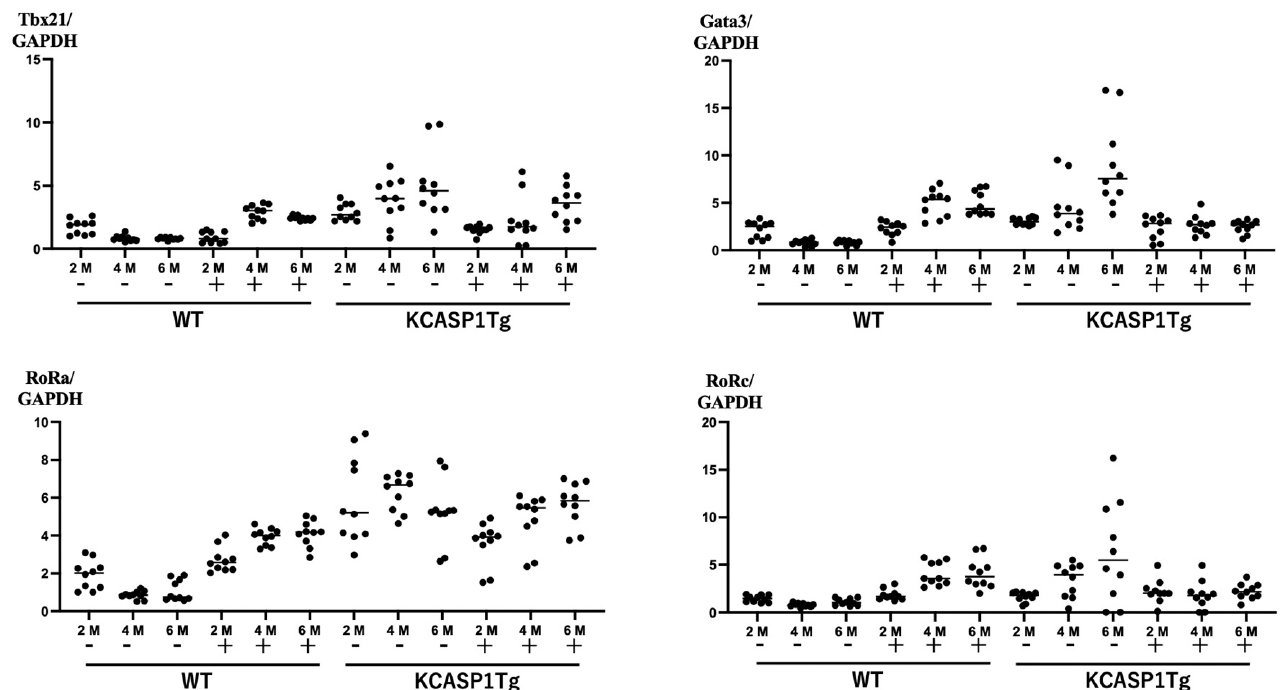
Figure 3. Expression of nuclear transcription factors. The graphs represent the relative expression of the indicated transcription factors with respect to the housing-keeping gene-GAPDH of mononuclear cells before and 4 h post-culture. In KCASP1Tg, with prolonged inflammation, T-bet , GATA3 , RoRa , and RoRc transcription factors were enhanced in the unstimulated condition, probably owing to the constitutive activation, which was suppressed upon simulation.